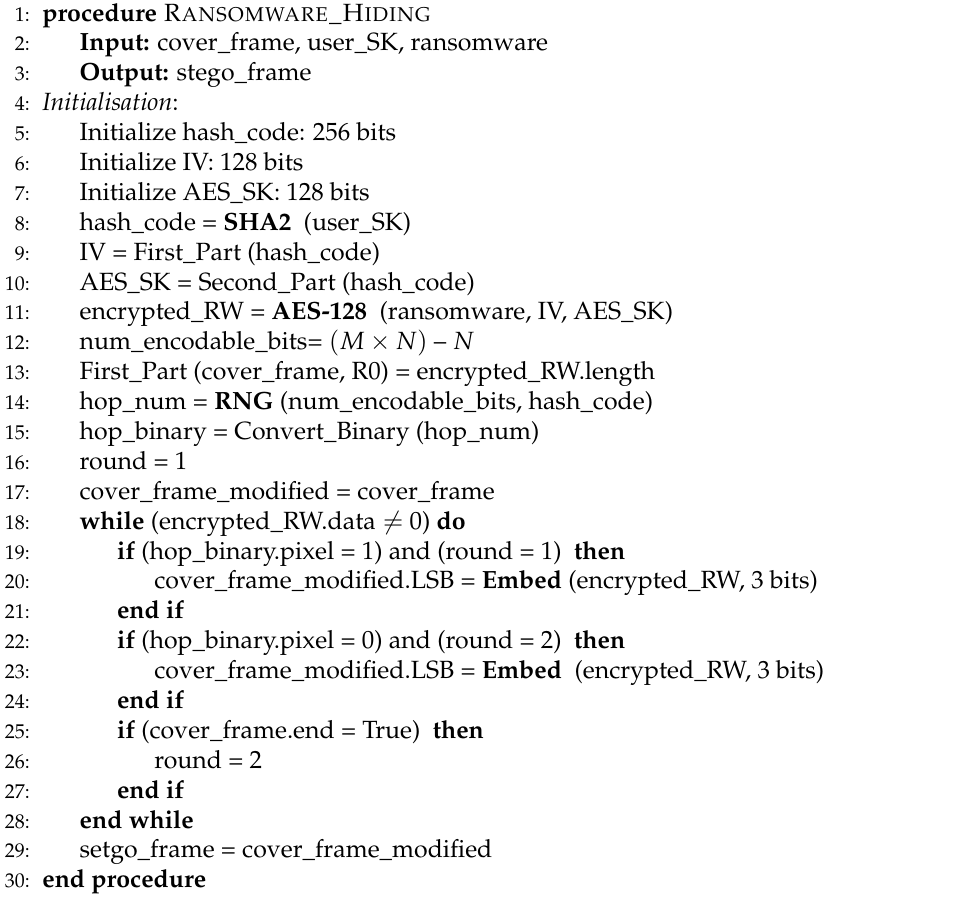
Algorithm 1 Ransomware Hiding